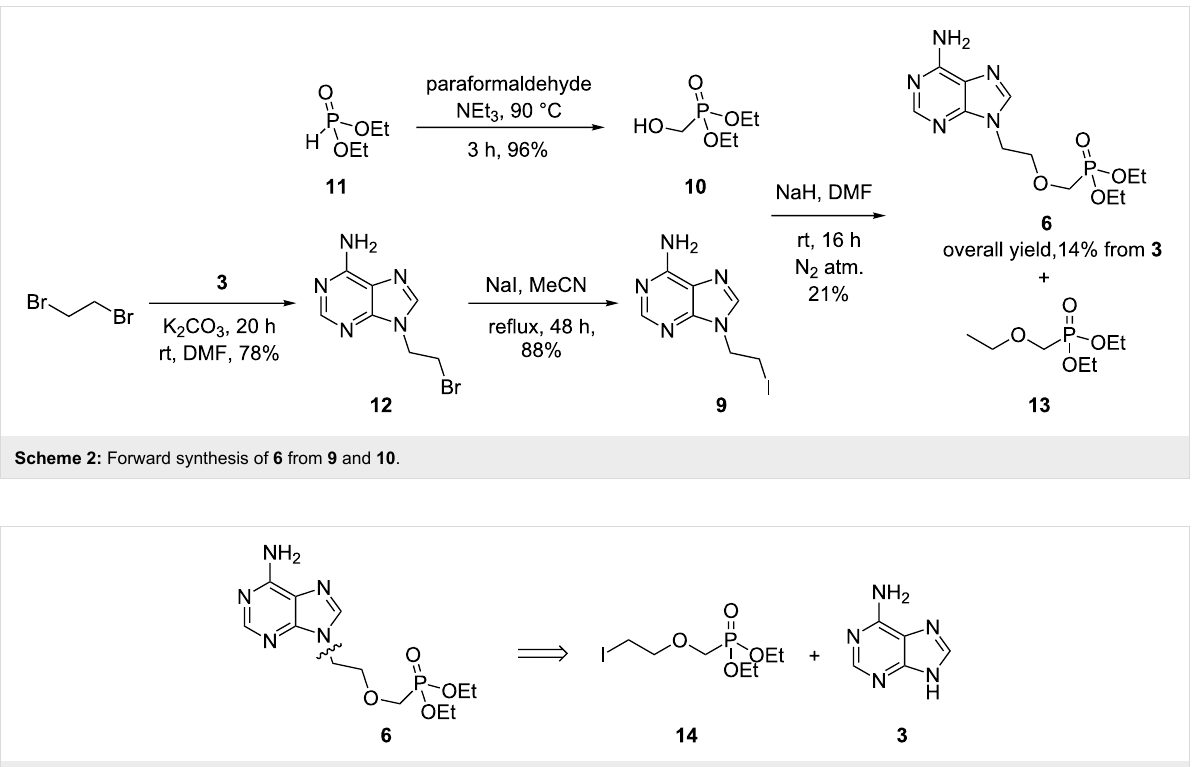
Figure 3: Retrosynthesis of 6 to synthons 14 and 3 .